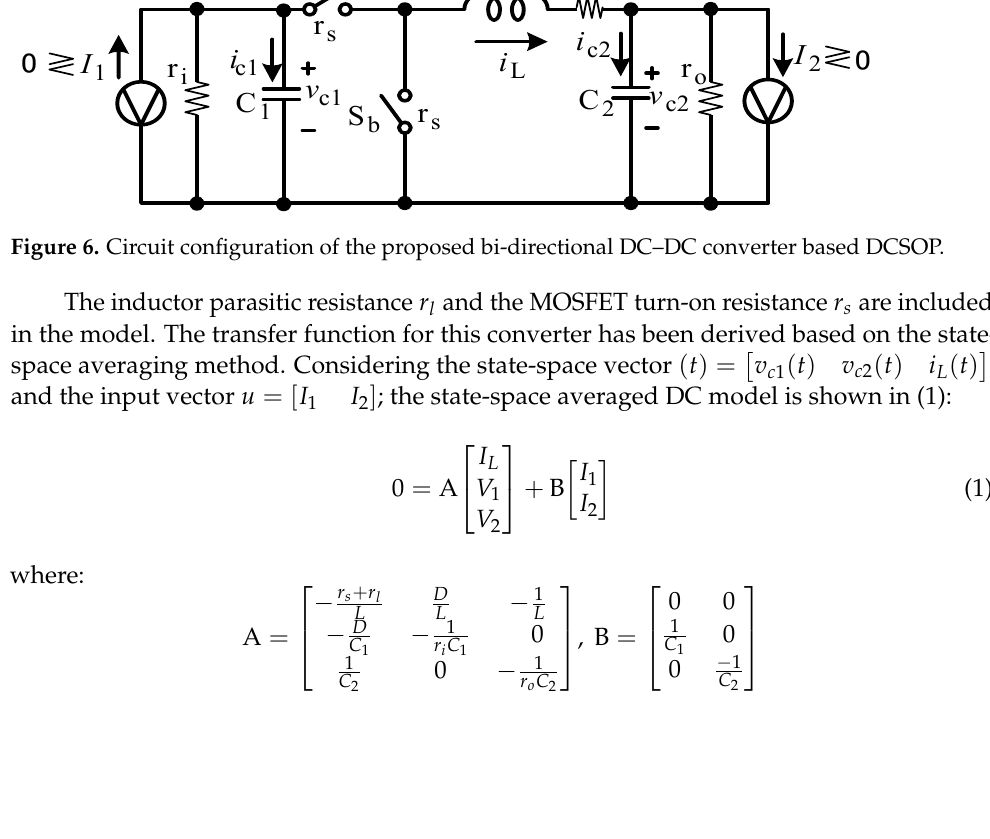
Figure 6. Circuit configuration of the proposed bi-directional DC–DC converter based DCSOP. The inductor parasitic resistance and the MOSFET turn-on resistance 𝑟𝑟 𝑙𝑙 cluded in the model. The transfer function for this converter has been derived based on